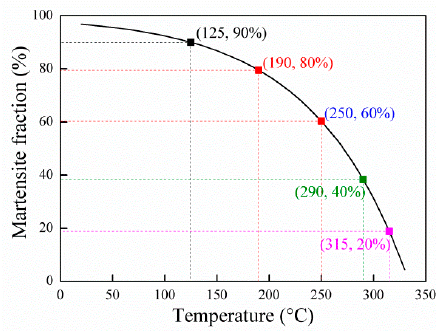
Figure 2. Different primary martensite fractions based on the K-M relationship.